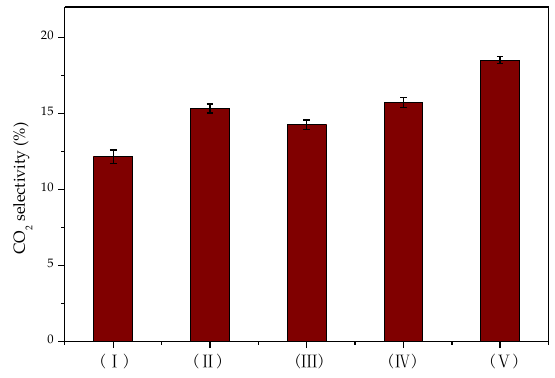
Figure 8. CO 2 selectivity in di ff erent reactors.